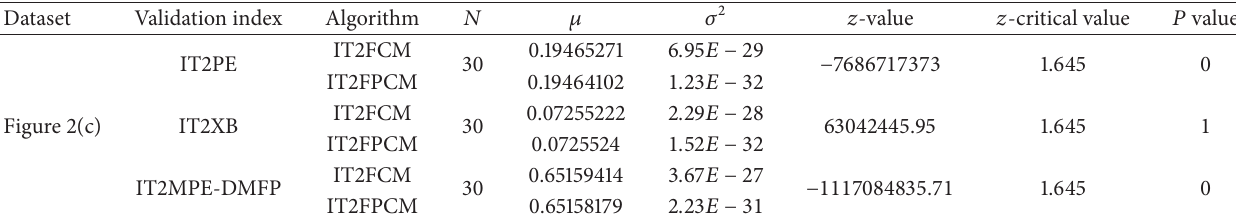
Table 36: Statistical test for the IT2PE, IT2XB, and IT2MPE-DMFP indices of validation for Figure 2(c) clustering.